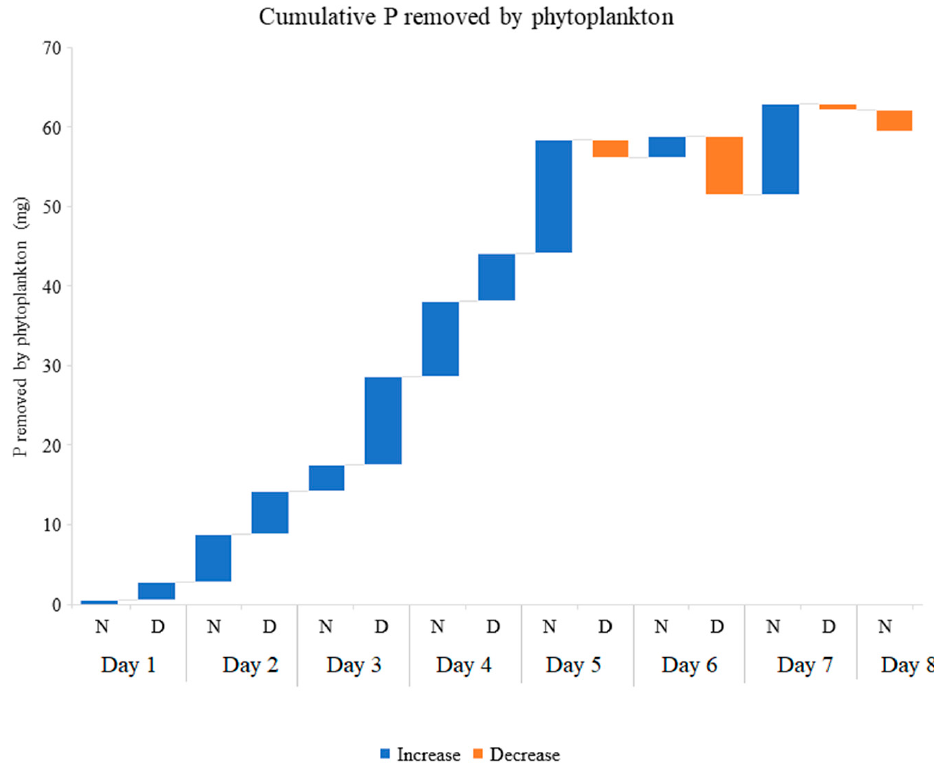
Figure 8. Cumulative Total Nitrogen removed by phytoplankton from 70 L of aquaculture effluent every 12 h. N (Night) indicates the Total Nitrogen removed between 8:00 pm and 8:00 am; D (Day) indicates the Total Nitrogen removed between 8:00 am and 8:00 pm. The graph shows the average of three replicates.